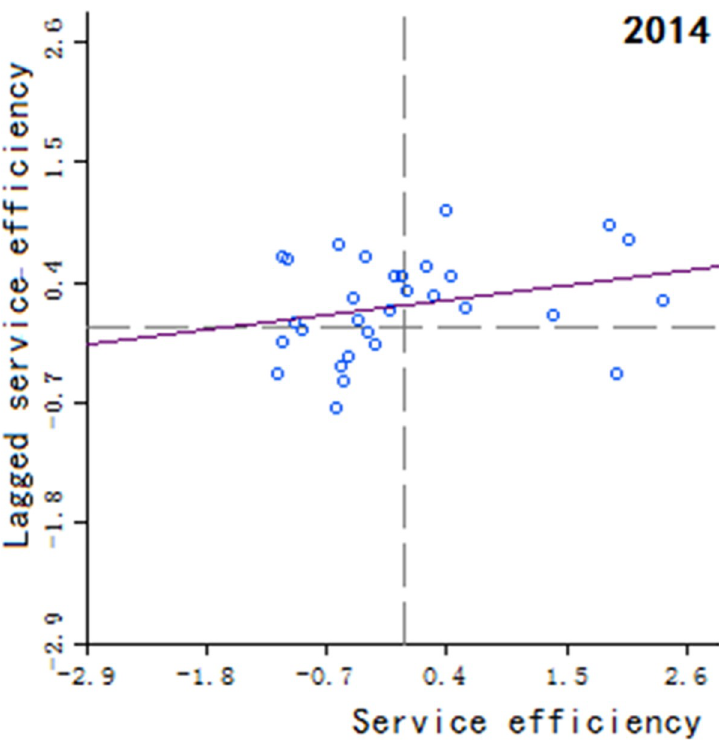
Fig 7. Scatter plot of China’s regional medical and health service level distribution from 2004 to 2018.